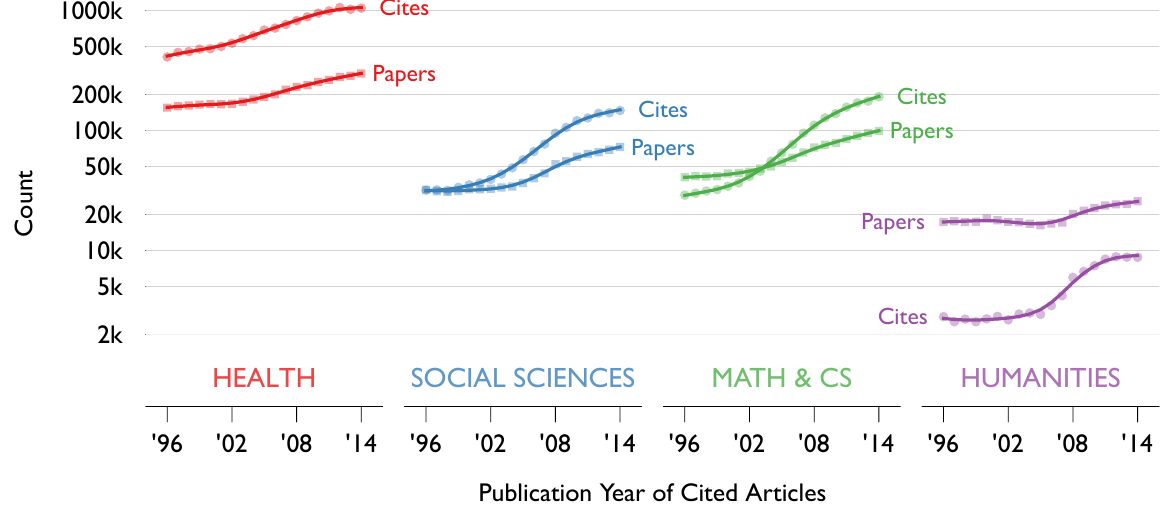
Figure 1: Number of journal articles published 1996–2014 and citations to those articles within two years of publication. Notes : Compiled from the Web of Science (Clarivate Analytics). See section S1 of the online supplement for the composition of the four broad categories shown above. All curves are smoothing splines with a span of 0.5. One exceptionally highly cited article in mathematics and computer science is